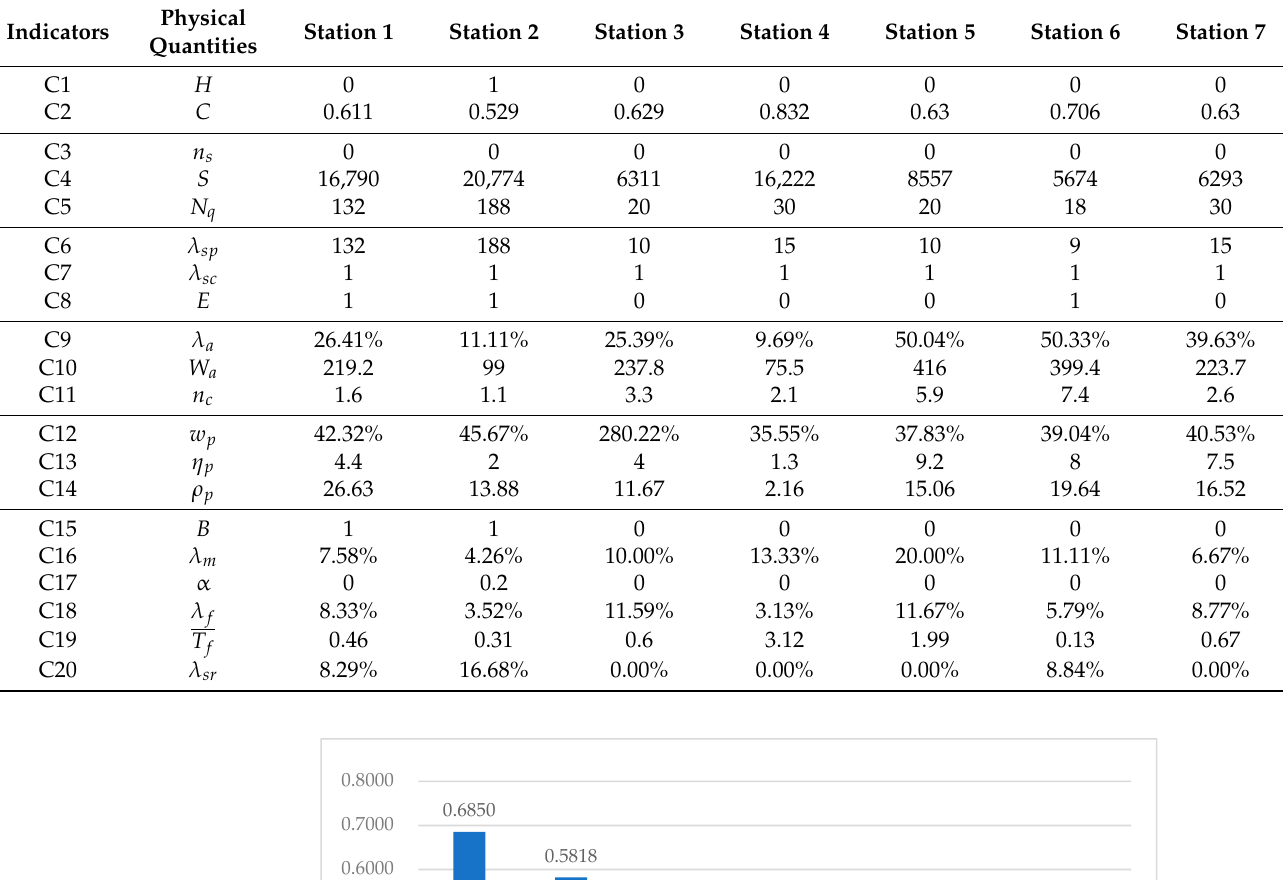
Table 7. The physical quantities of the evaluation indicators of seven charging stations.